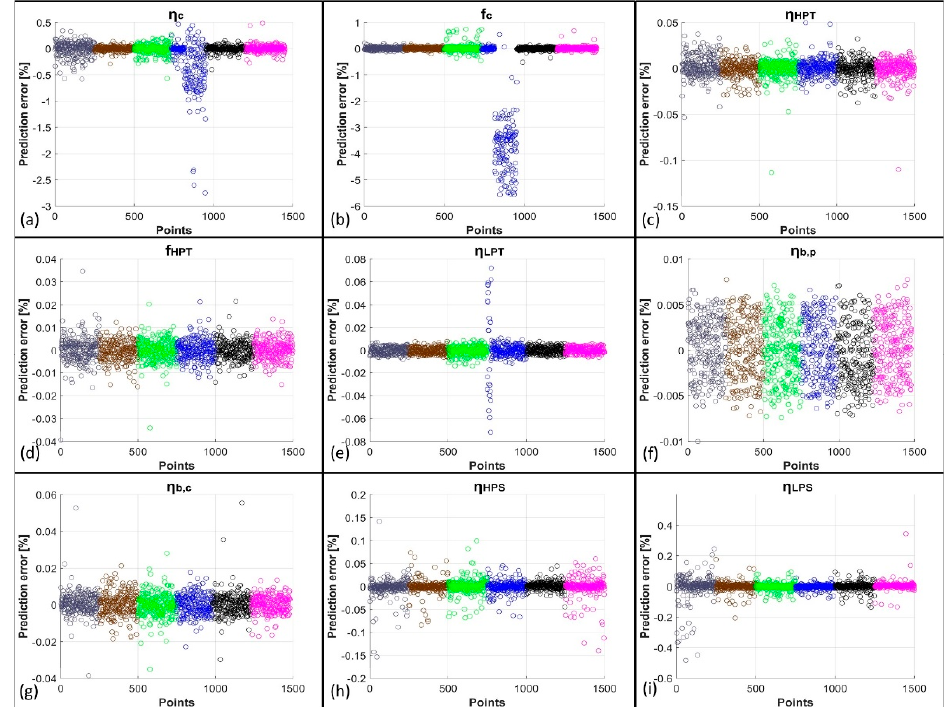
Figure 4. ( a – i ) Percentage errors between FFNN predictions and targets about the PPs related to the first five degradation conditions. Grey: START-A; brown: START-B; green: MAXPOW-A; blue: MAXPOW-B; black: MAXDUR-A; magenta: MAXDUR-B.